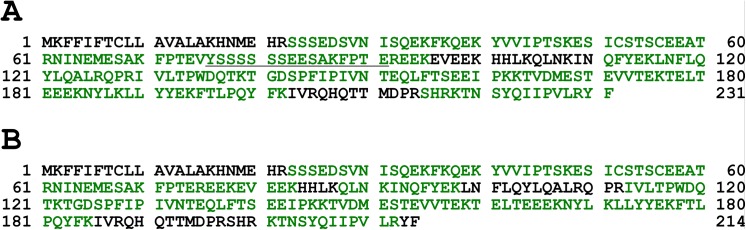
Combined sequence coverage (all bands excised) of αS2-casein in mare with +/+ genotype (A) and Δ/Δ genotype (B).From the +/+ genotype only unique peptides were identified for the longer αS2-casein form (Accession no. A0A0C5DH76, 231 AAs). Sequence which is unique to A0A0C5DH76 is underlined. For the Δ/Δ genotype only unique peptides were identified for the shorter alphaS2-casein form (Accession no. D2KAS0, 214 AAs). Sections in green represents parts of the protein which were identified by the sequest-HT algorithm.